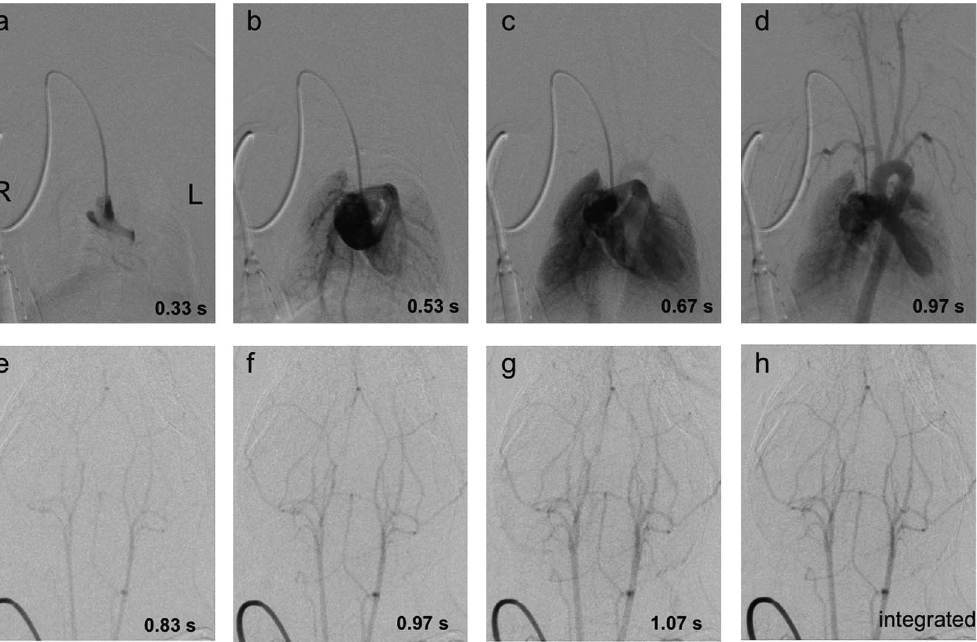
Figure 5. Digital subtraction angiography of a C57/BL6 mouse was performed during injection of 100 m l Iomeprol 300 using the VAMP. Sequential enhancement of the right atrium (a), the right ventricle and lung arteries (b), the lung parenchyma (c), the left ventricle, the aorta and supra-aortic arteries (d) is shown. A digital subtraction angiography of the cerebral vessels is shown the second row. Images (e)–(g) show the sequential enhancement of the cerebral arteries within one second. Integration of images was performed to improve image quality (h).